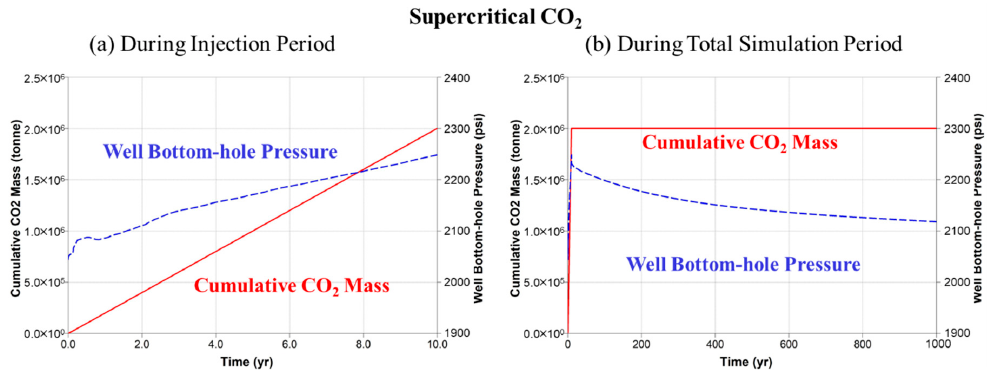
Figure 4. The injection scenario used in this study ( a ) Schematic diagram of the injection interval in the YTP formation; ( b ) schematic diagram of the supercritical CO 2 scenario; ( c ) schematic diagram of the dissolved CO 2 solution scenario.